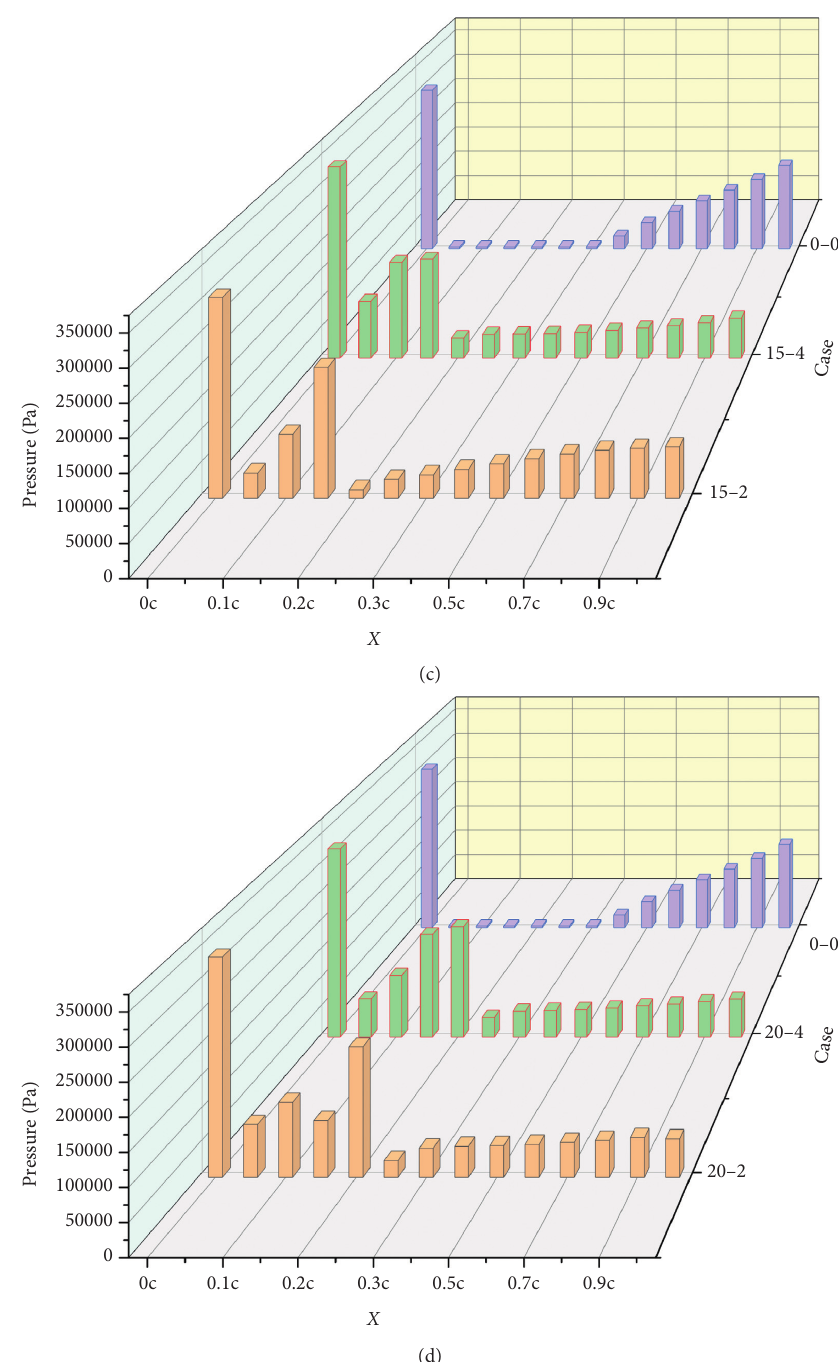
Figure 7: Pressure graph. (a) Near-wall pressure curve of “5 ∼ ” series hydrofoil. (b) Near-wall pressure curve of “10 ∼ ” series hydrofoil. (c) Near-wall pressure curve of “15 ∼ ” series hydrofoil. (d) Near-wall pressure curve of “20 ∼ ” series